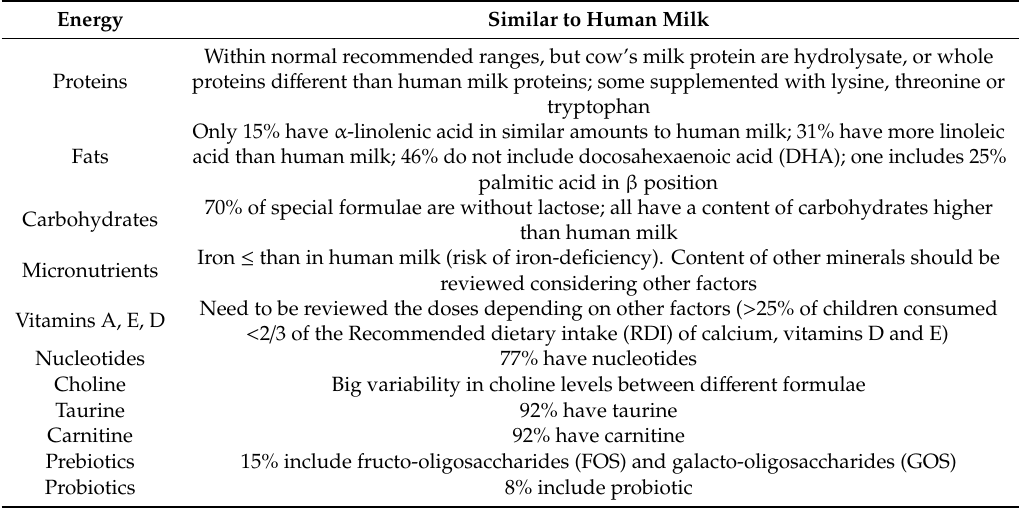
Table 2. General characteristics of infant formulas for cow’s milk protein allergy (modified from Fiocchi A., et al.; World Allergy Organ J 2016